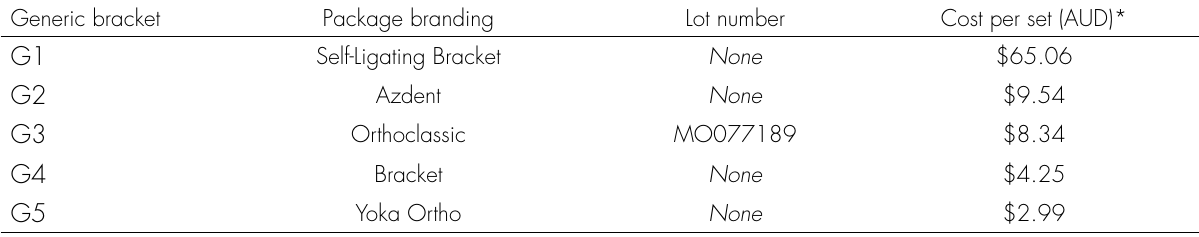
Table I. A description of the generic brackets used in the experiment. Package branding relates to information found on the packaging. The price was for the complete set, which excluded molar brackets, in all brands except G1. *Price on www.eBay.com.au at